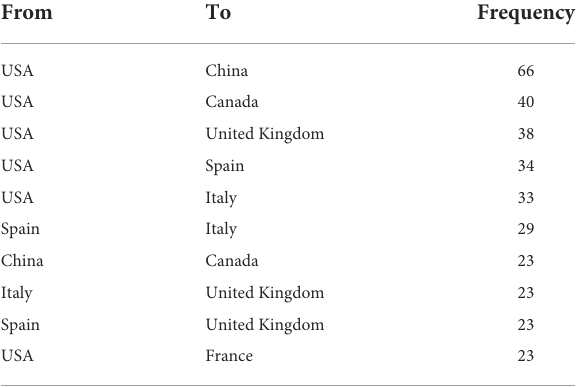
TABLE 2 The cooperation among countries/regions. From To Frequency